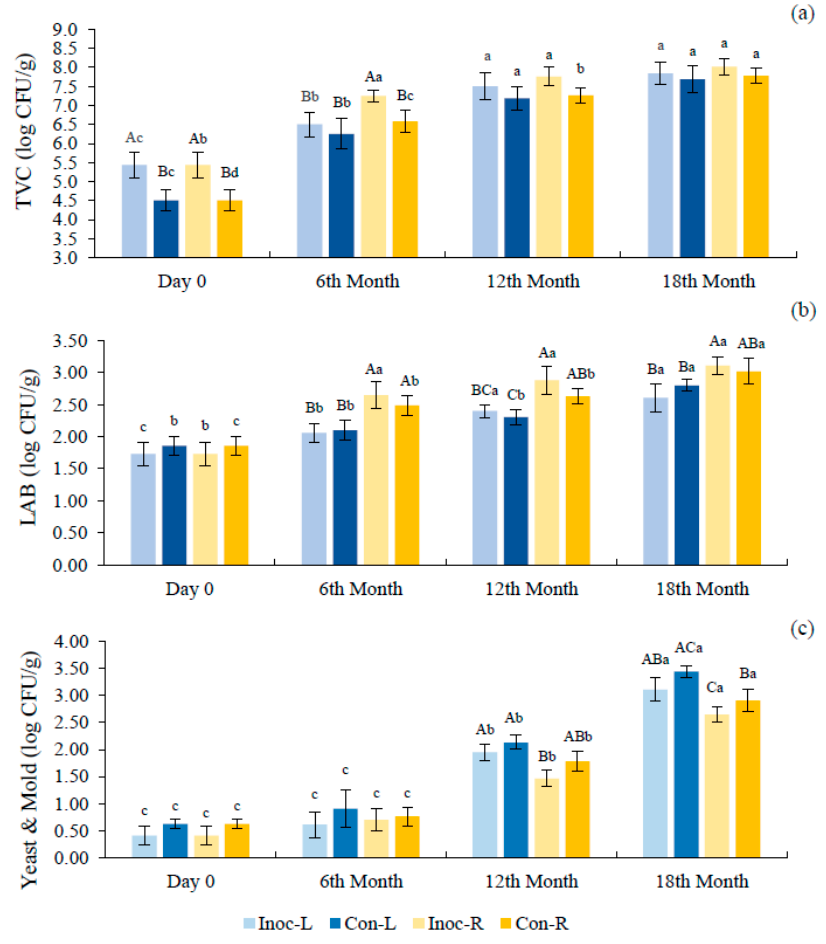
Figure 1. Total viable count (TVC) ( a ), lactic acid bacteria (LAB) ( b ), and yeast and mold count ( c ) of shrimp paste with/without B. subtilis K-C3 inoculation during 18 months of low (4 °C) and room (28 °C) temperature storage. Different lowercase letters indicate significant differences ( p < 0.05), as affected by storage time. Different uppercase letters indicate significant differences ( p < 0.05) between samples at the same storage time.